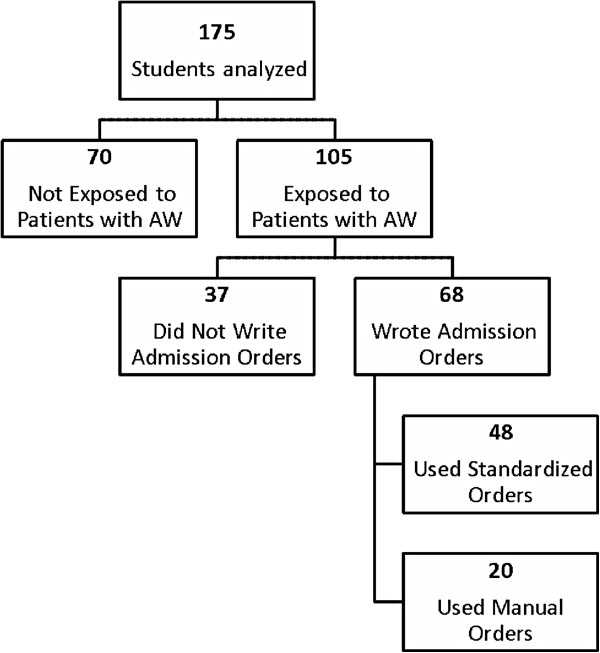
Flow sheet of students analyzed, exposed to patients with AW, wrote admission and exposed to standardized orders for AW.